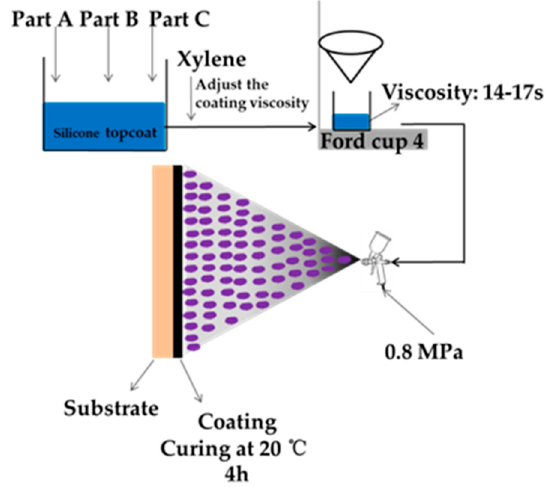
Figure 2. Spraying process of silicone topcoat.